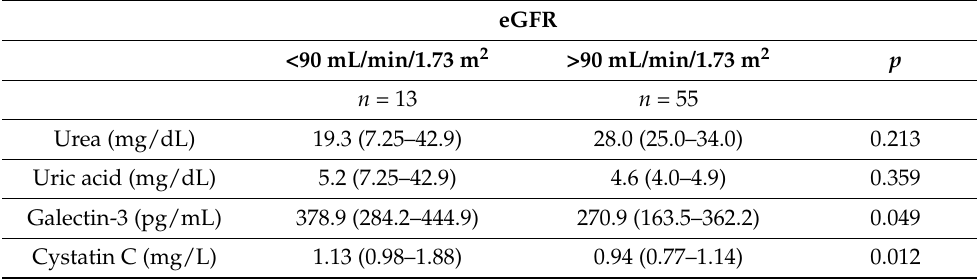
Table 3. Summary of the biochemical parameters in children with a congenital solitary functioning kidney according to estimated glomerular filtration rate.